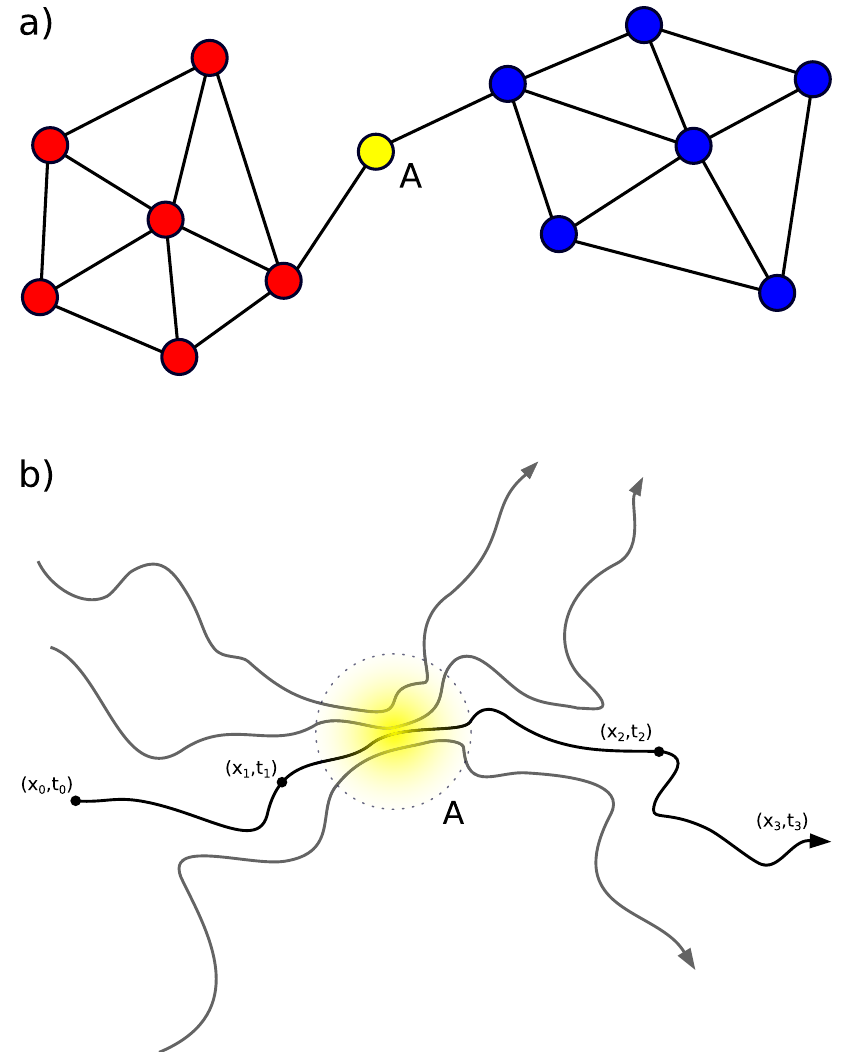
Fig. 1 Betweenness concept in networks and dynamical systems. a A small network composed by nodes (colored circles) and links (black segments). The central node A behaves as a bottleneck for the network since all the paths connecting the blue with the red part must go through it. Indeed, node A, despite being attached to only two links, has the maximum value of betweenness centrality. b A set of Lagrangian trajectories (black lines) in a generic dynamical system. Each trajectory represents the evolution of an initial condition in space and time. Initial conditions, depending on the case studied, can be associated either to states of a system or to particles and agents moving across it. The yellow region A highlights a region where trajectories from different origins are choked into a narrow passage before being dispersed again. Similarly to node A in a , this region would qualitatively represent a bottleneck of the system and should be associated to a high value of